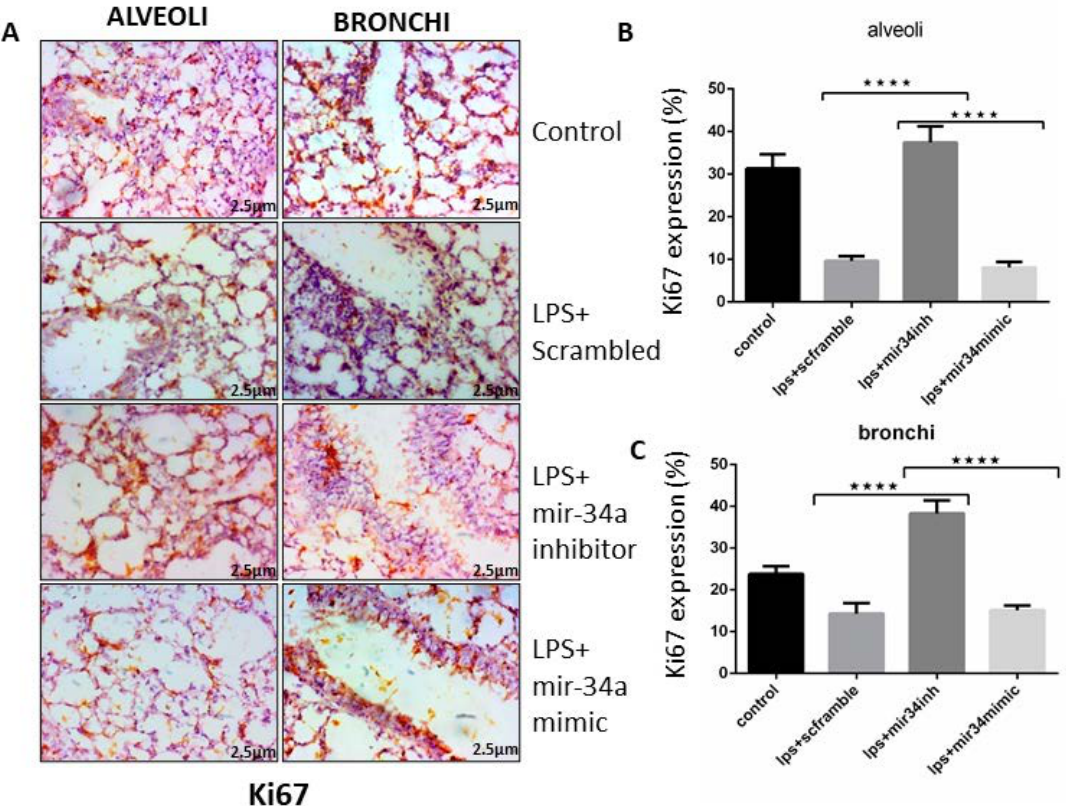
Figure 7. miR-34a reduced cell proliferation. ( A ) Immune-histological images of mice lung tissue showed the expression of Ki67 after treatment with LPS along with miR-34a inhibitor, mimics, and scrambled treated groups. ( B , C ) Expression of Ki67 quantified in alveolar and bronchial areas and statistically analyzed by two-way ANOVA. **** p < 0.0001 ( n = 4) .